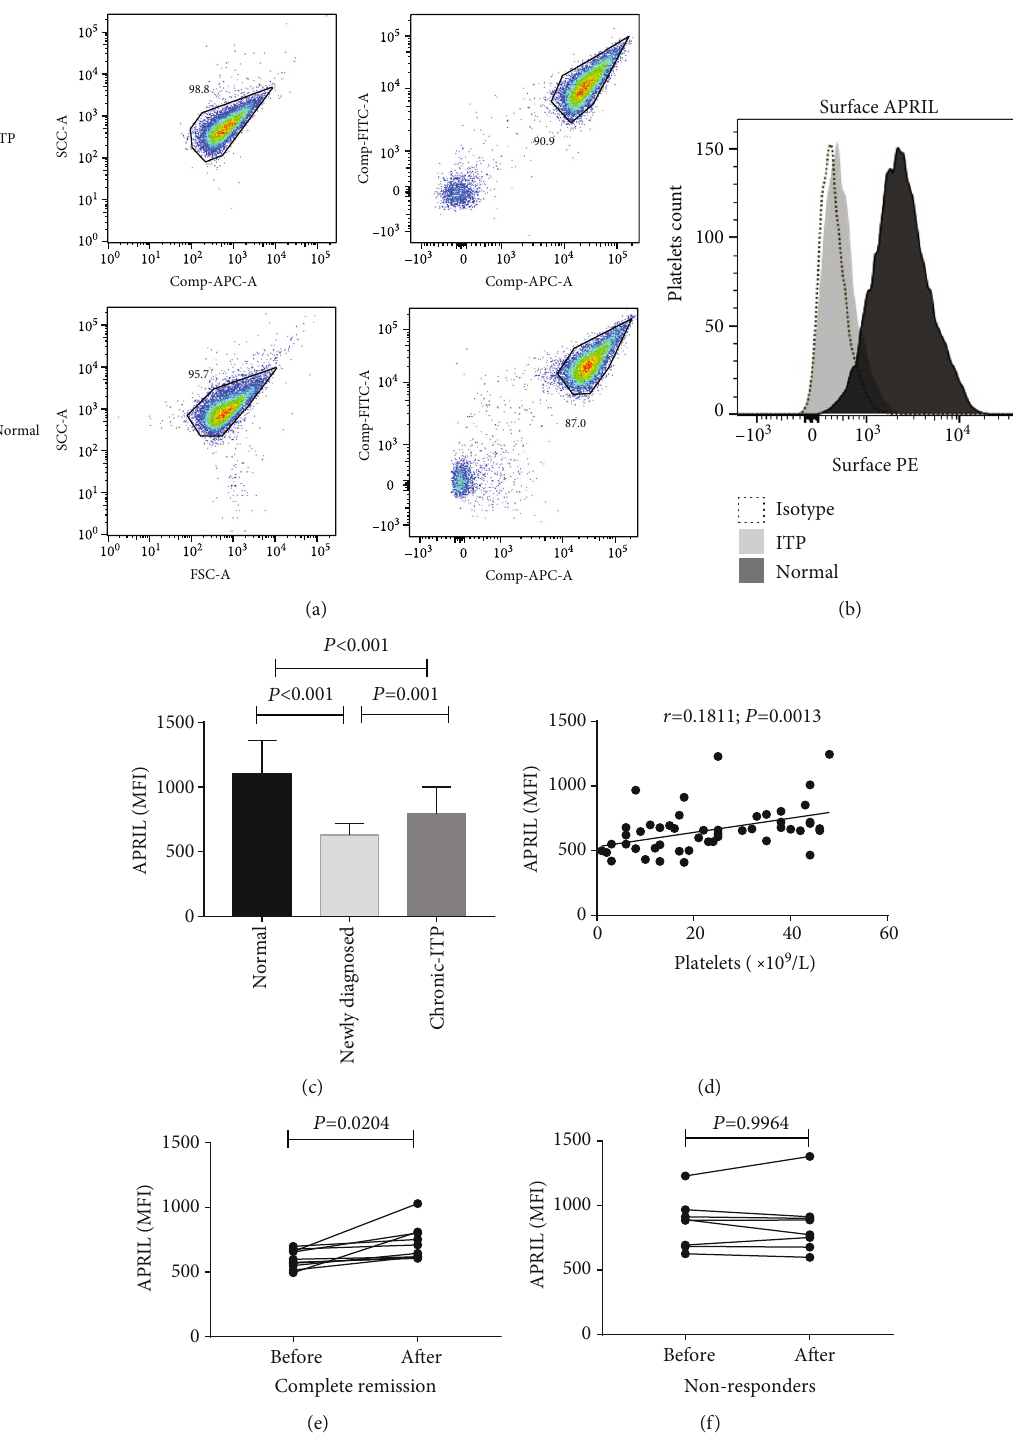
Figure 2: Decreased surface expression of APRIL on platelets in ITP patients. (a) Platelets from healthy donors and ITP patients were isolated by fl ow cytometry based on surface expression of APRIL. Forward and side light scatter (FSC and SSC, respectively) and intact cell gates (left panels) were used for platelet gating (right panels). (b) Representative histograms show surface APRIL and isotype labeling in gated platelets. (c) MFI of surface APRIL expression in gated platelets from healthy donors and ITP patients. (d) Spearman ’ s test showed that APRIL expression in ITP patients ( n = 50 ) was highly correlated with platelet count. (e, f) Di ff erences in APRIL MFI in ITP patients in complete remission ( n = 10 ) (e) and nonresponders ( n = 8 ) (f) before and after